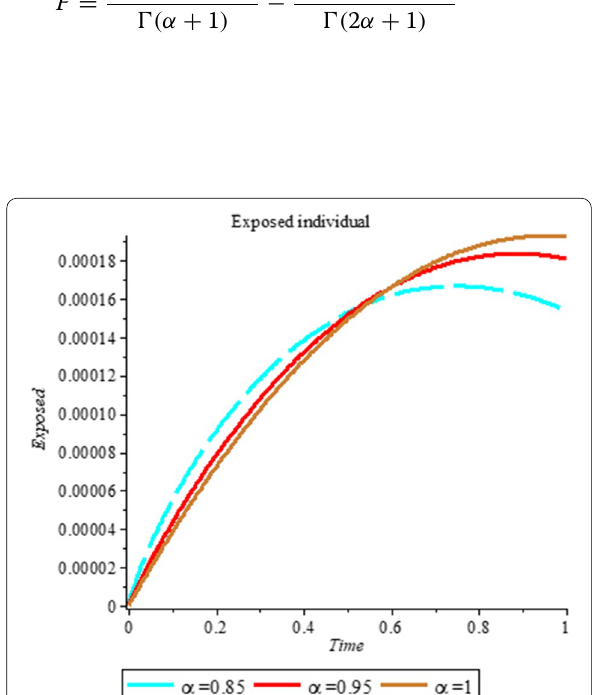
Fig. 1 Plot shows the behavior of S ( t ) at different values of fractional order α